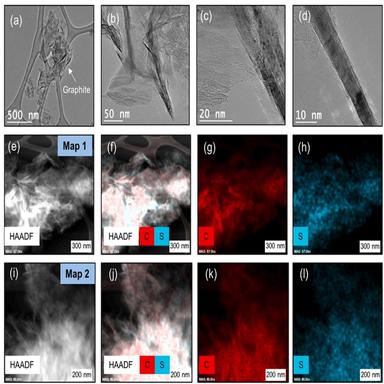
TEM and HAADF-STEM images, as well as STEM-EDS elemental mappings of the S-graphite: Bright-field TEM image (a-b), Phase contrast TEM images (c-d), HAADF STEM image (e), Overlay EDS map of carbon and sulfur with HAADF image (f), EDS map of carbon (g), EDS map of sulfur (h), higher magnifications (i-l) of regions (e-h).